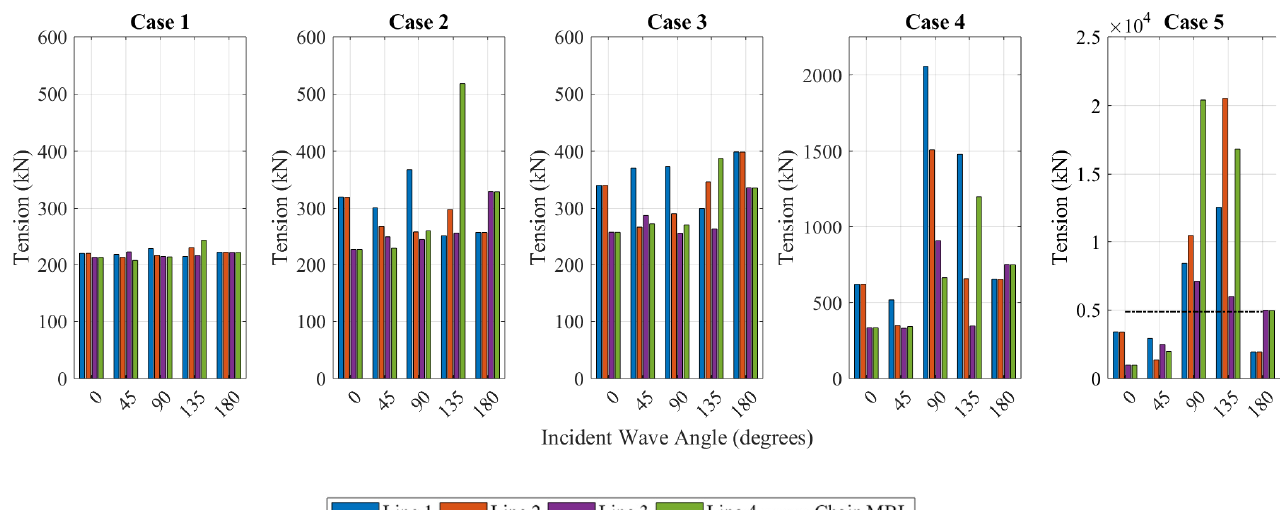
Figure 12. Numerical results of maximum tensions in the mooring lines for Test Cases 1–5.